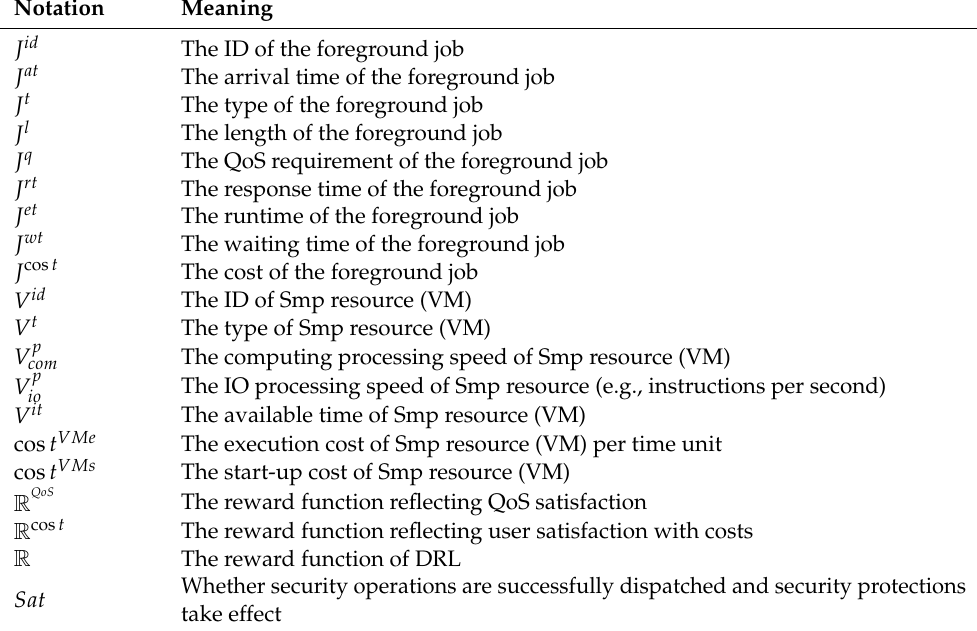
Table 1. Notations used in our scheduling